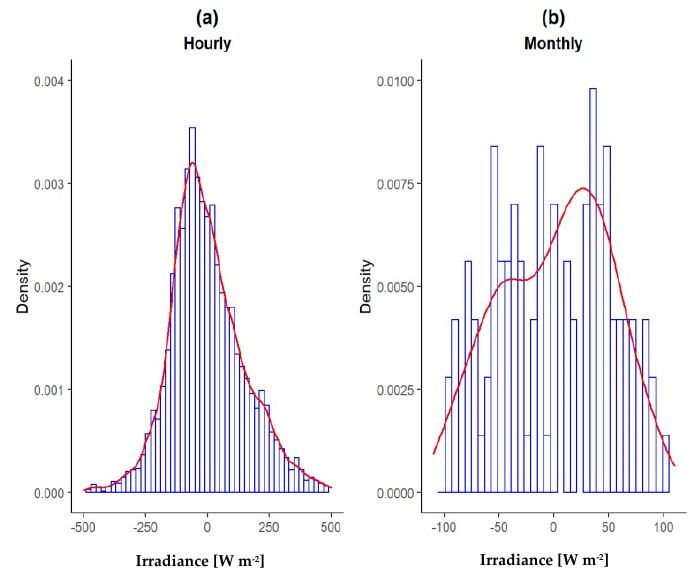
Figure 12. Histogram of residuals frequency for hourly vs. monthly GHI profiles. ( a ) Shows the irradiance distribution for the hourly profile. ( b ) Shows how the irradiance is distributed for the monthly profile.